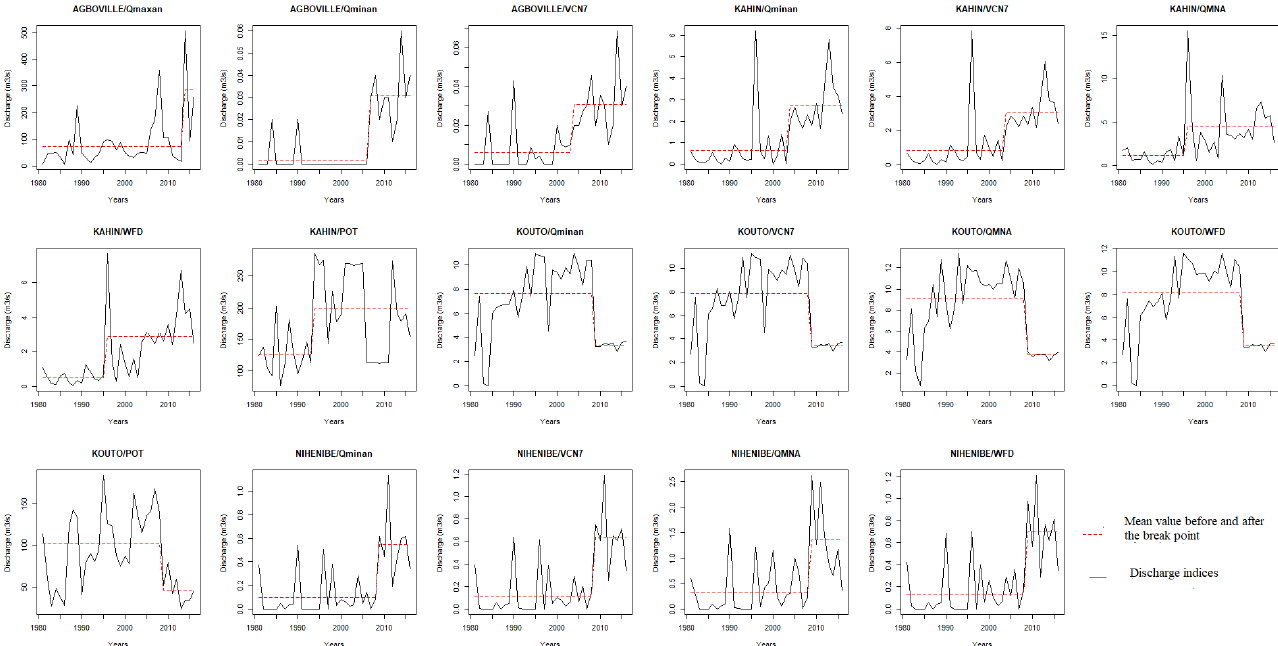
Figure A3. Homogeneous period for the break point analysis.